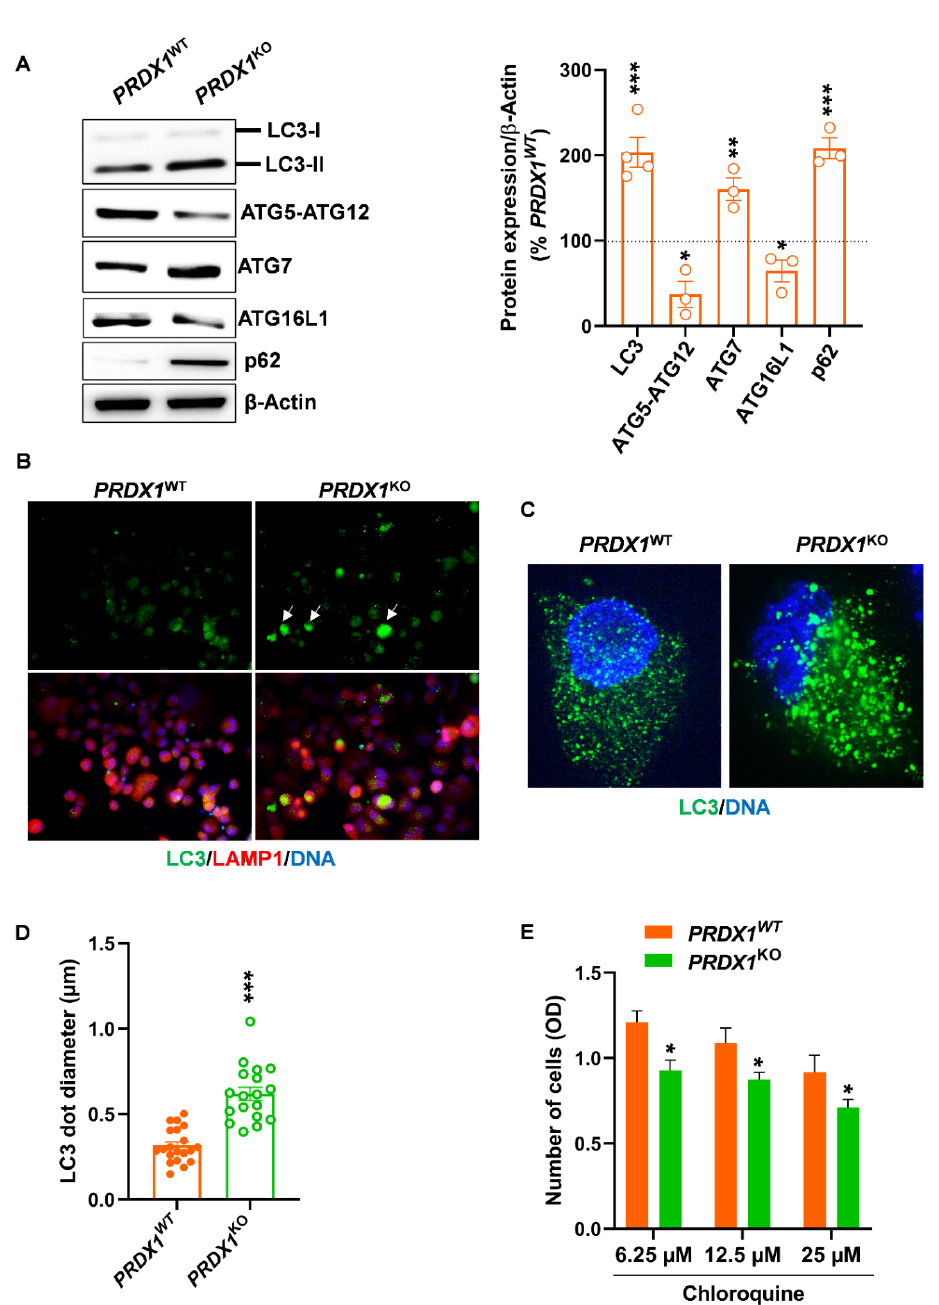
Figure 4. Peroxiredoxin-I (PRX-I) ablation disrupts basal autophagic flux in human pancreatic ductal adenocarcinoma (PDAC) cells. ( A ) Western blot for autophagy markers and their corresponding densitometric quantification. β -Actin was used as a loading control; Western blots were performed on three-to-four independent culture passages ( n = 3–4). The dashed line, set at 100%, represents the expression level in PRDX1 WT cells. ( B ) Representative pictures of Microtubule- associated protein 1A/1B-light chain (LC3) and Lysosomal-associated membrane protein 1 (LAMP1) immunolabeling on PRDX1 WT and PRDX1 KO cells; immunolabeling was performed on three independent culture passages ( n = 3). White arrows show autophagy-defective cells with large LC3 dots. ( C ) Representative confocal pictures of LC3 immunolabeling in one